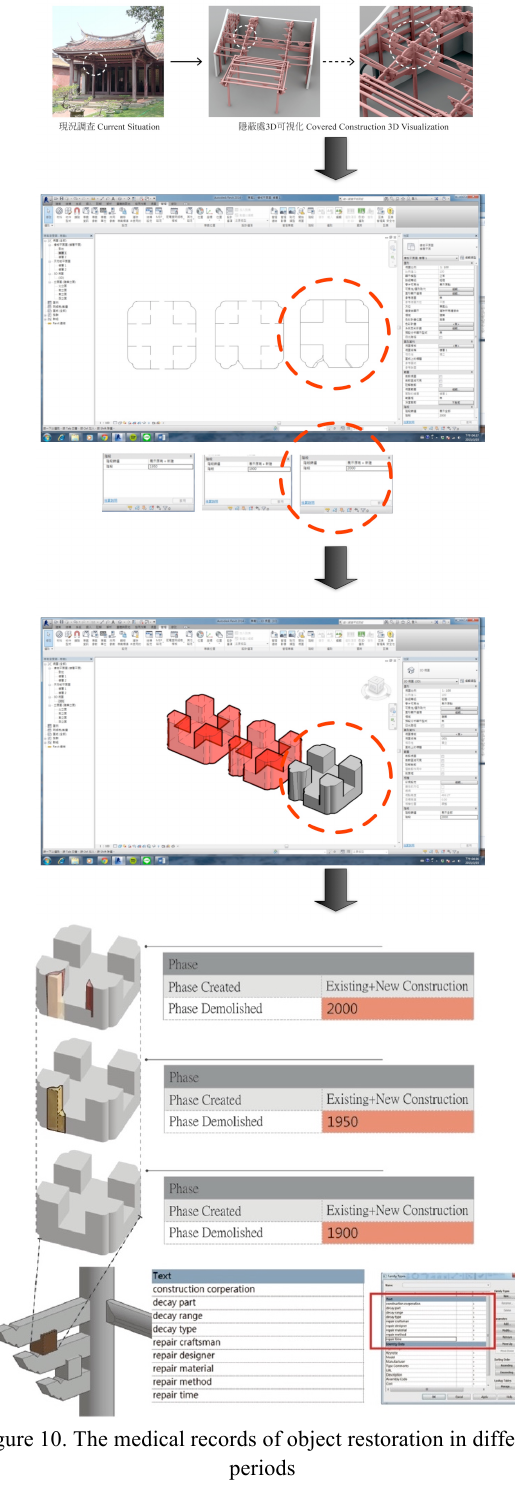
Figure 10. The medical records of object restoration in different periods